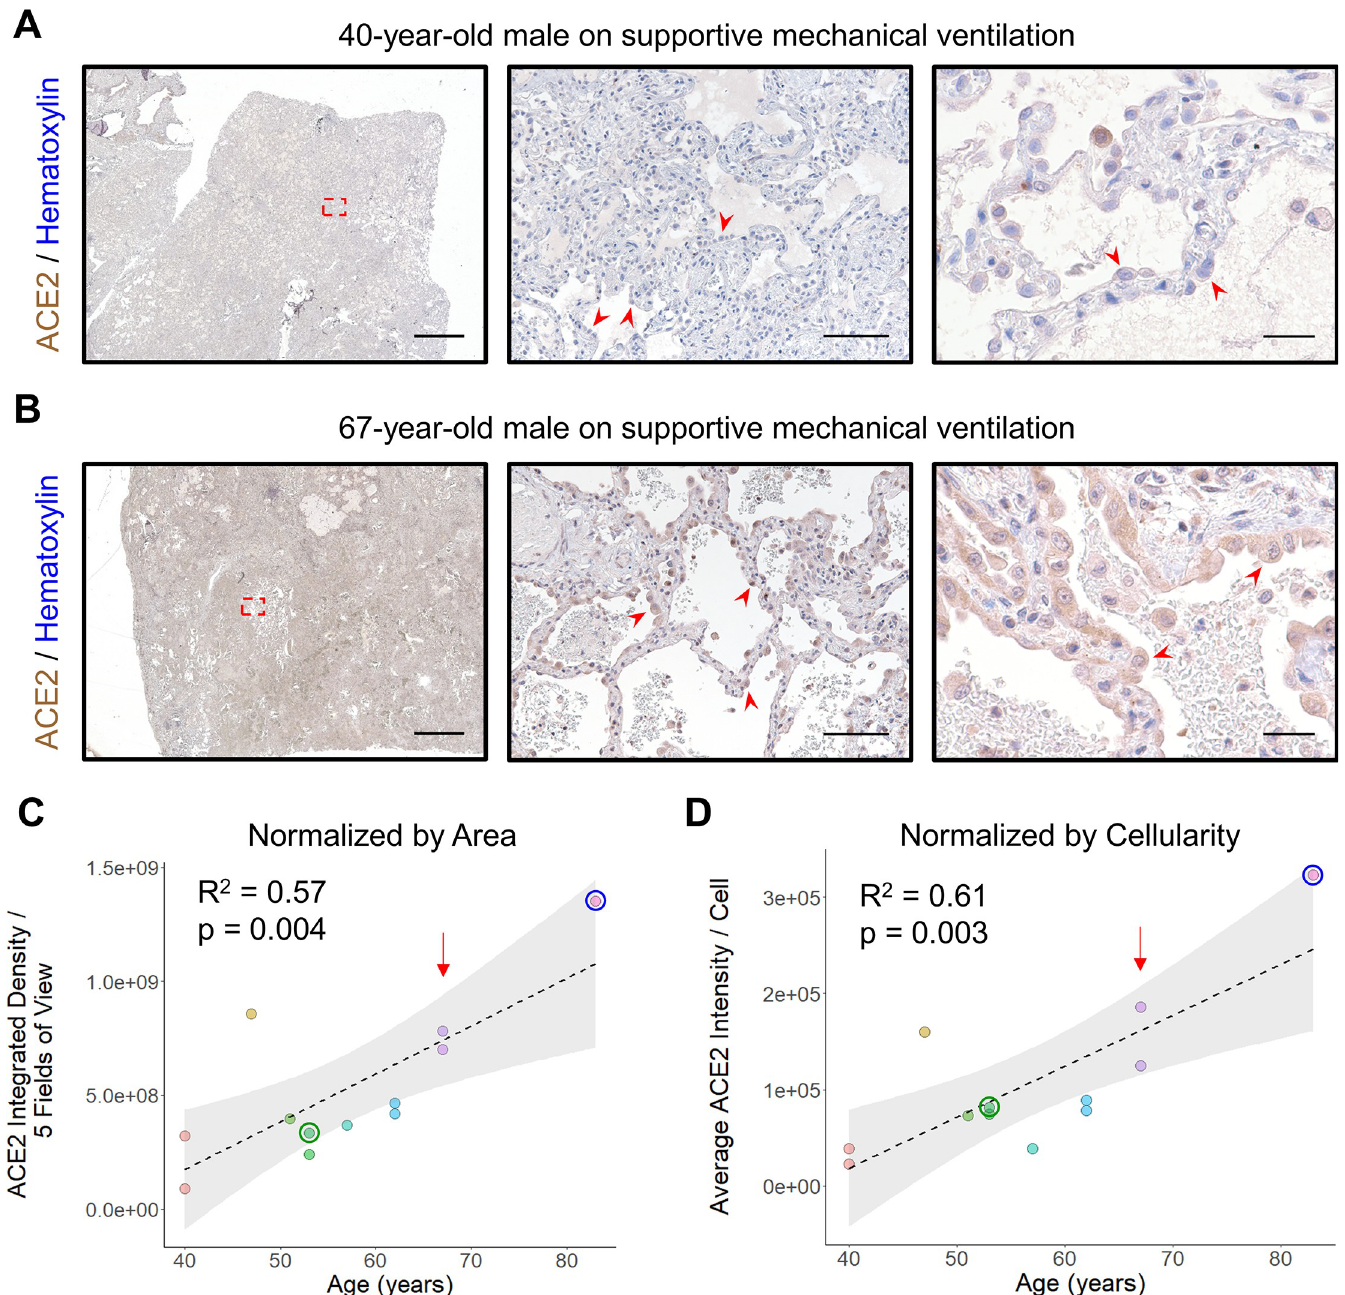
Fig 3. ACE2 protein expression increases with age in ventilated patients. A) Representative images of lung stained for ACE2 from a 40-year-old man with acute lung injury are shown using a 1x objective (left, scale bar 3mm) with the region outlined by the red dashed box magnified at low power (middle, scale bar 200 μ m) and a second field at high power (right, scale bar 50 μ m). Clusters of reactive AT2 cells (red arrowheads) are present along the alveolar septum which exhibit low level ACE2 expression. B) Representative images of lung stained for ACE2 from a 67-year-old man with acute lung injury superimposed on fibrosing interstitial lung disease are shown using a 1x objective (left, scale bar 3mm) with the region outlined by the red dashed box magnified at low power (middle, scale bar 200 μ m) and a second field at high power (right, scale bar 50 μ m). Numerous reactive AT2 cells (red arrowheads) exhibiting nucleomegaly and abundant cytoplasm can be seen demonstrating strong ACE2 staining. C) Quantitative IHC for ACE2 was carried out on samples from ventilated patients (n = 12 samples from 11 patients). Total ACE2 expression from 5 low power fields is plotted relative to the patient’s age at the time of specimen collection. A linear fit to the data is indicated by the dashed line with the 95% confidence interval highlighted in grey. D) The same specimens quantitated in (C) were normalized by cellularity and the average ACE2 expression per cell is plotted along with a linear fit to the data and its 95% confidence interval. The red arrow in (C) and (D) indicates a patient providing 1 sample from the left lung and 1 sample from the right lung during the same procedure, utilized as a control for intra-individual reproducibility. The green and blue circle in (C) and (D) indicate the staining intensity of the samples depicted in Fig 5A and 5B, respectively. Sections were stained for ACE2 using DAB and counterstained with hematoxylin.